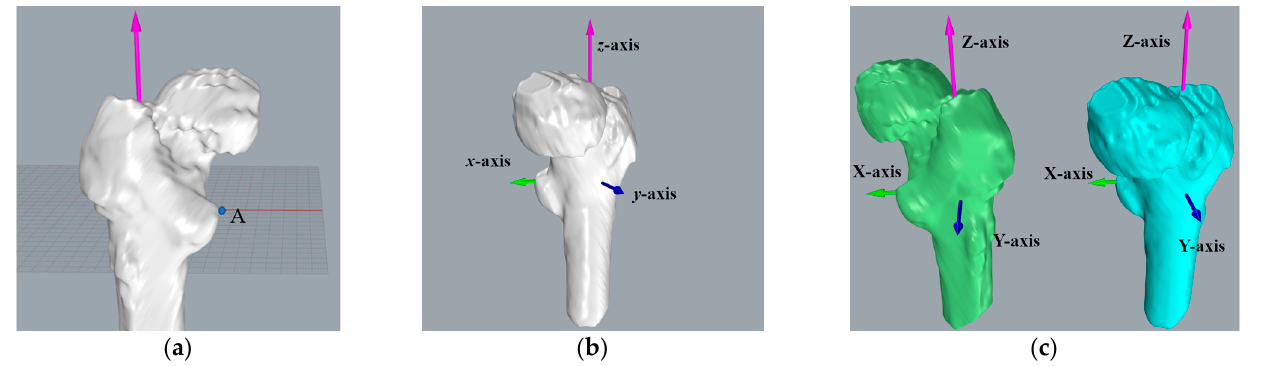
Figure 10. Establishing the right and left femoral coordinate system: ( a ) reference point A in the lesser trochanter region. ( b ) left femoral coordinate system, and ( c ) comparison of the left and right femoral coordinate systems.